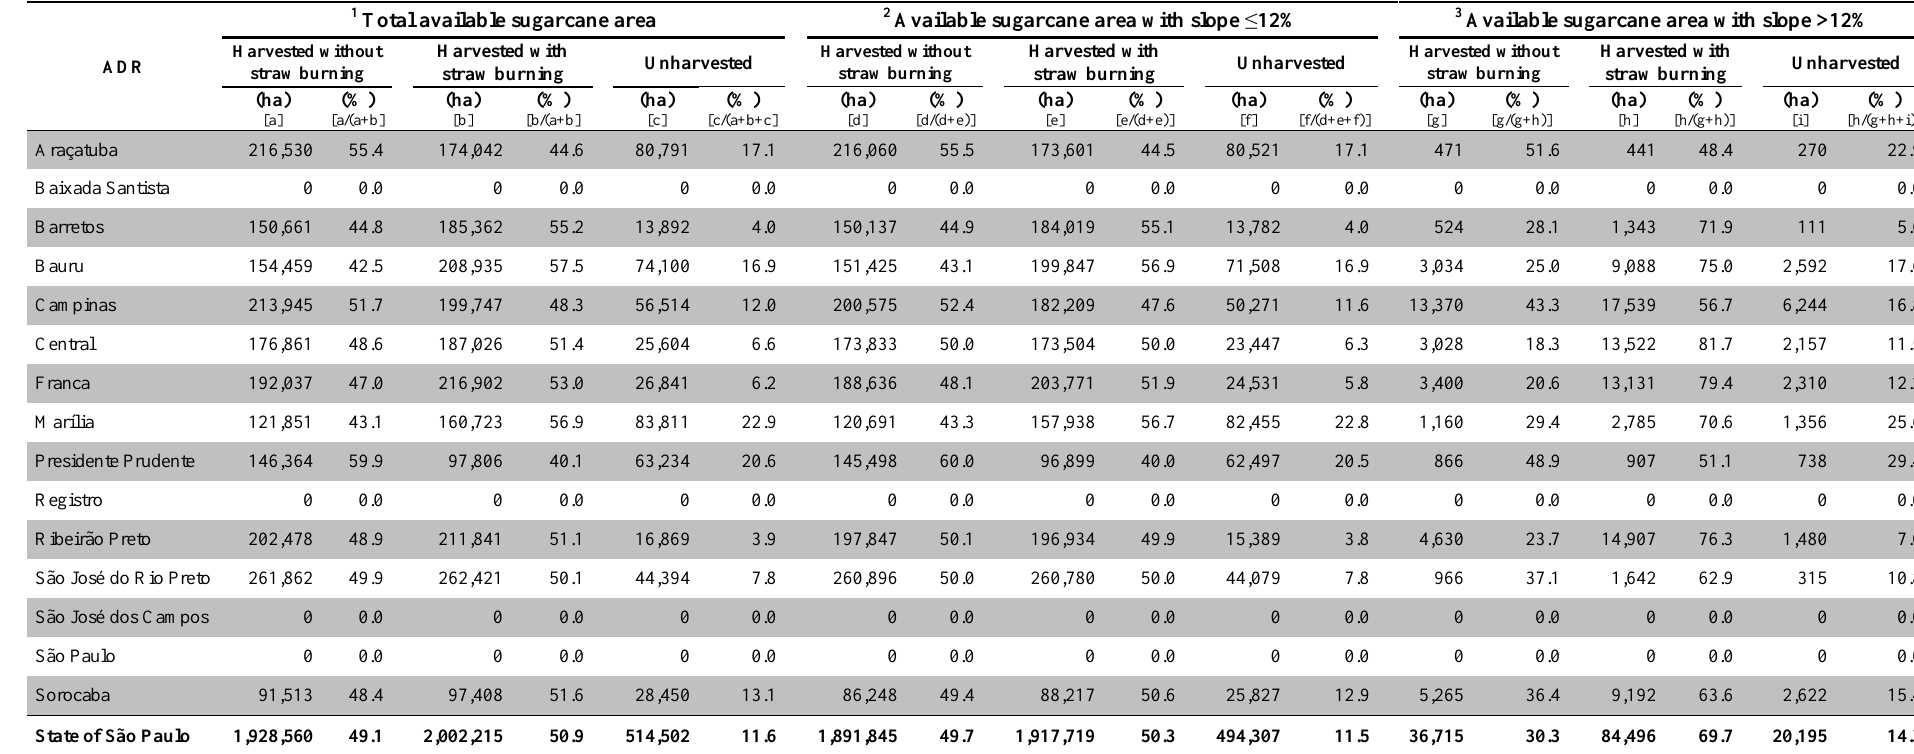
Table 2. Information on harvested and unharvested sugarcane area for the Administrative Regions (ADRs) of São Paulo state, crop year 2008/09: 1) total available sugarcane area: (a) harvested with straw burning, (b) harvested without straw burning, and c) unharvested; (2) available sugarcane area with slope ≤12%: (d) harvested with straw burning, (e) harvested without straw burning, and (f) unharvested; (3) available sugarcane area with slope ≤12%: (g) harvested without straw burning, (h) harvested with straw burning, and (i)